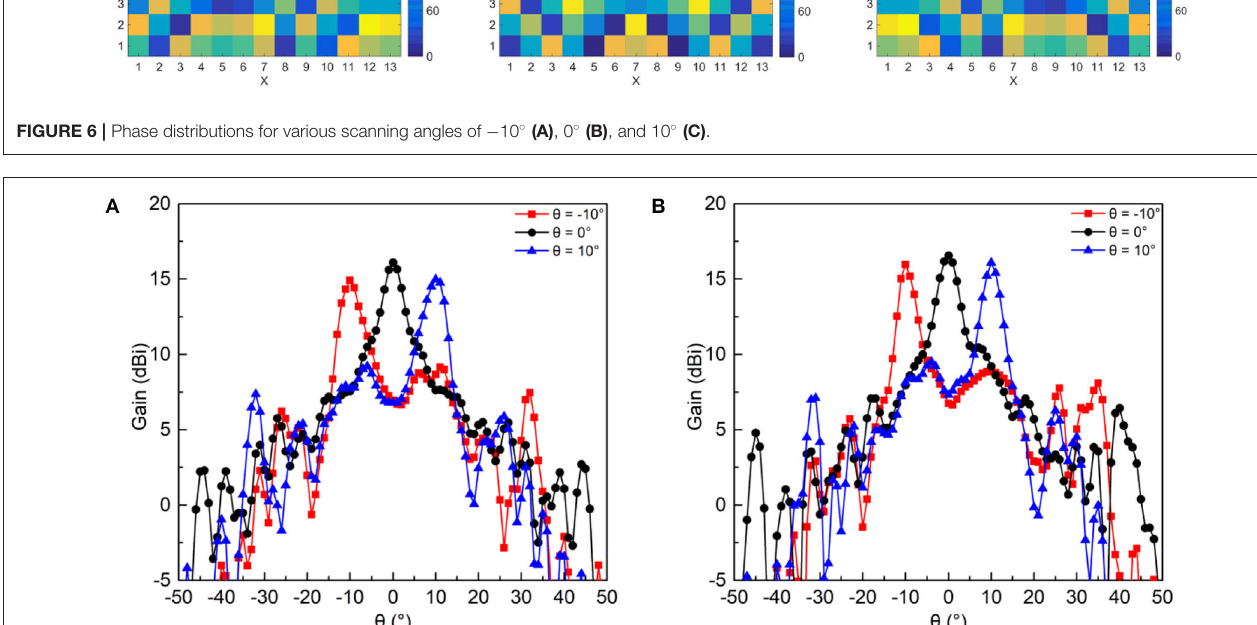
FIGURE 7 | Simulated radiation patterns at 115 GHz for an azimuth angle φ of 90 ◦ (A) and an azimuth angle φ of 0 ◦ (B) .